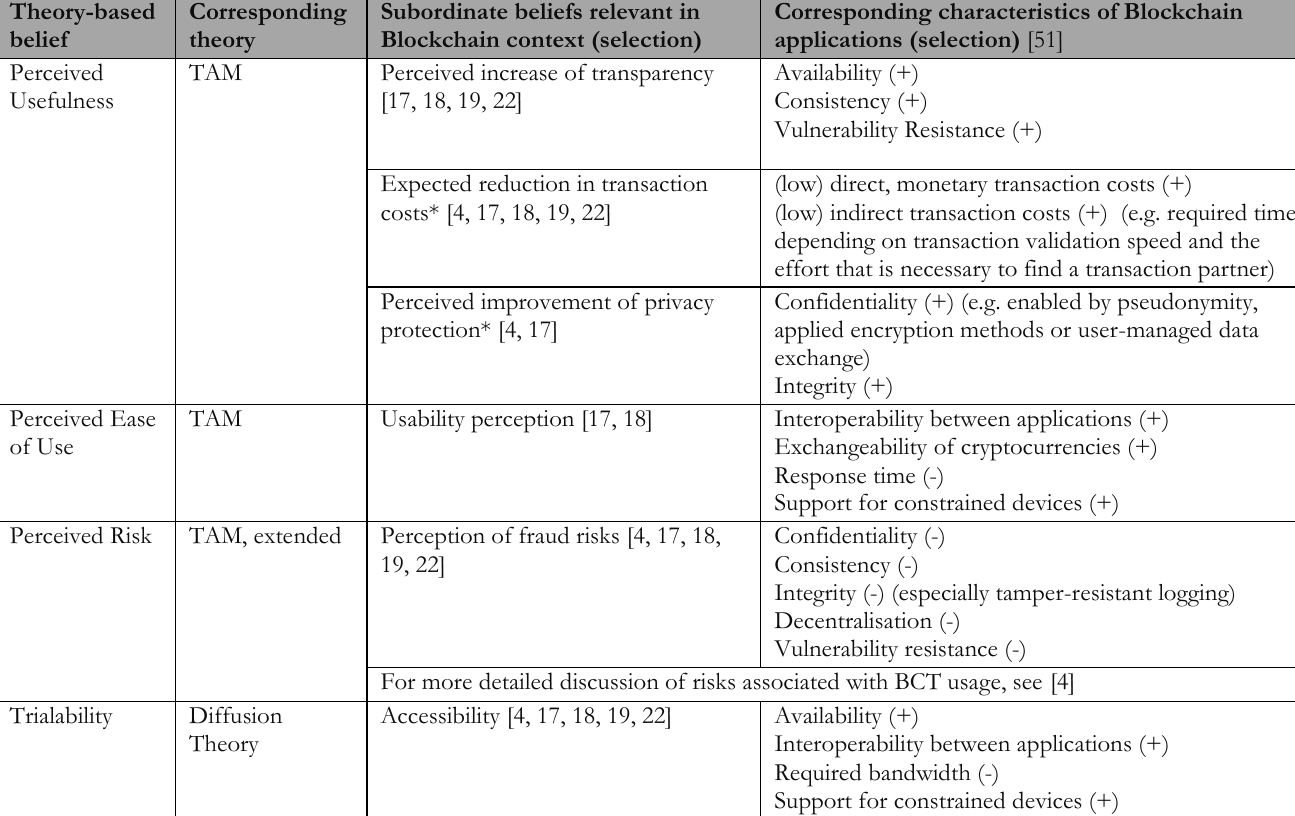
Table 1. Derivation of theory-based beliefs.